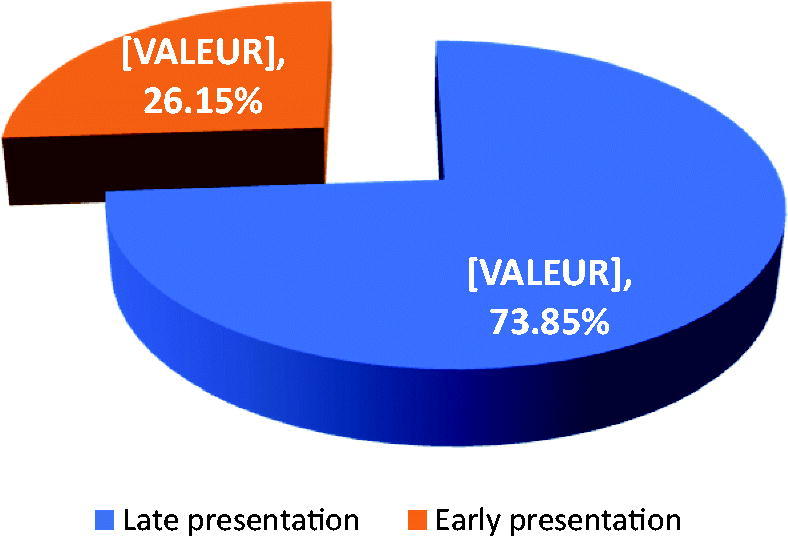
Distribution of the population according to the manner of presentation.